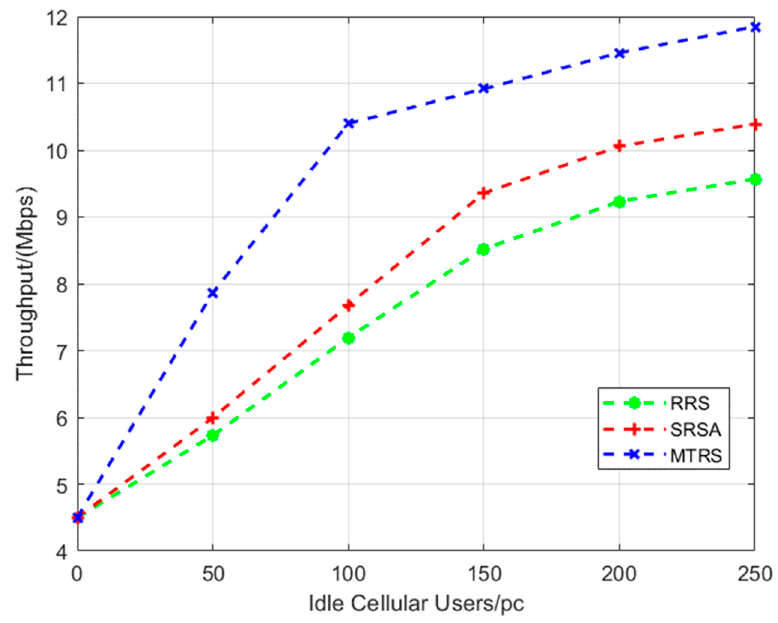
Figure 3. Variation curve of outage probability with the number of idle cellular users.